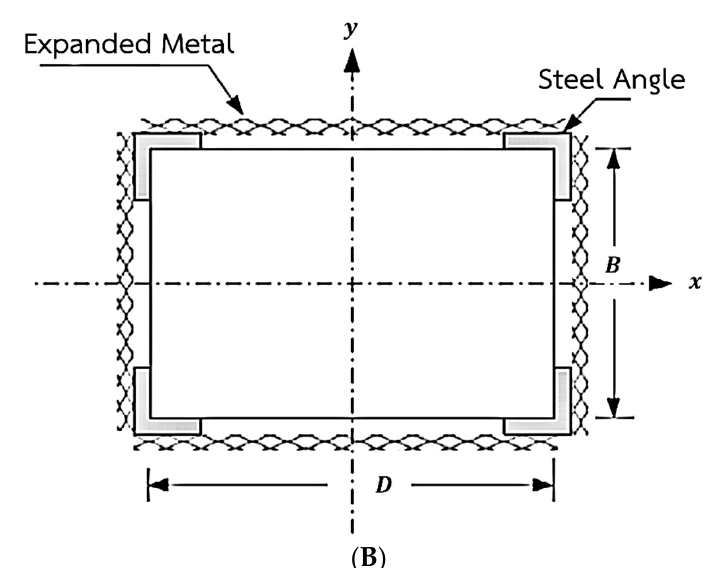
Figure 1. The rigid frame was reinforced with expanded metal. ( A ) Reinforced rigid frame; ( B ) Cross-section of the reinforced column.